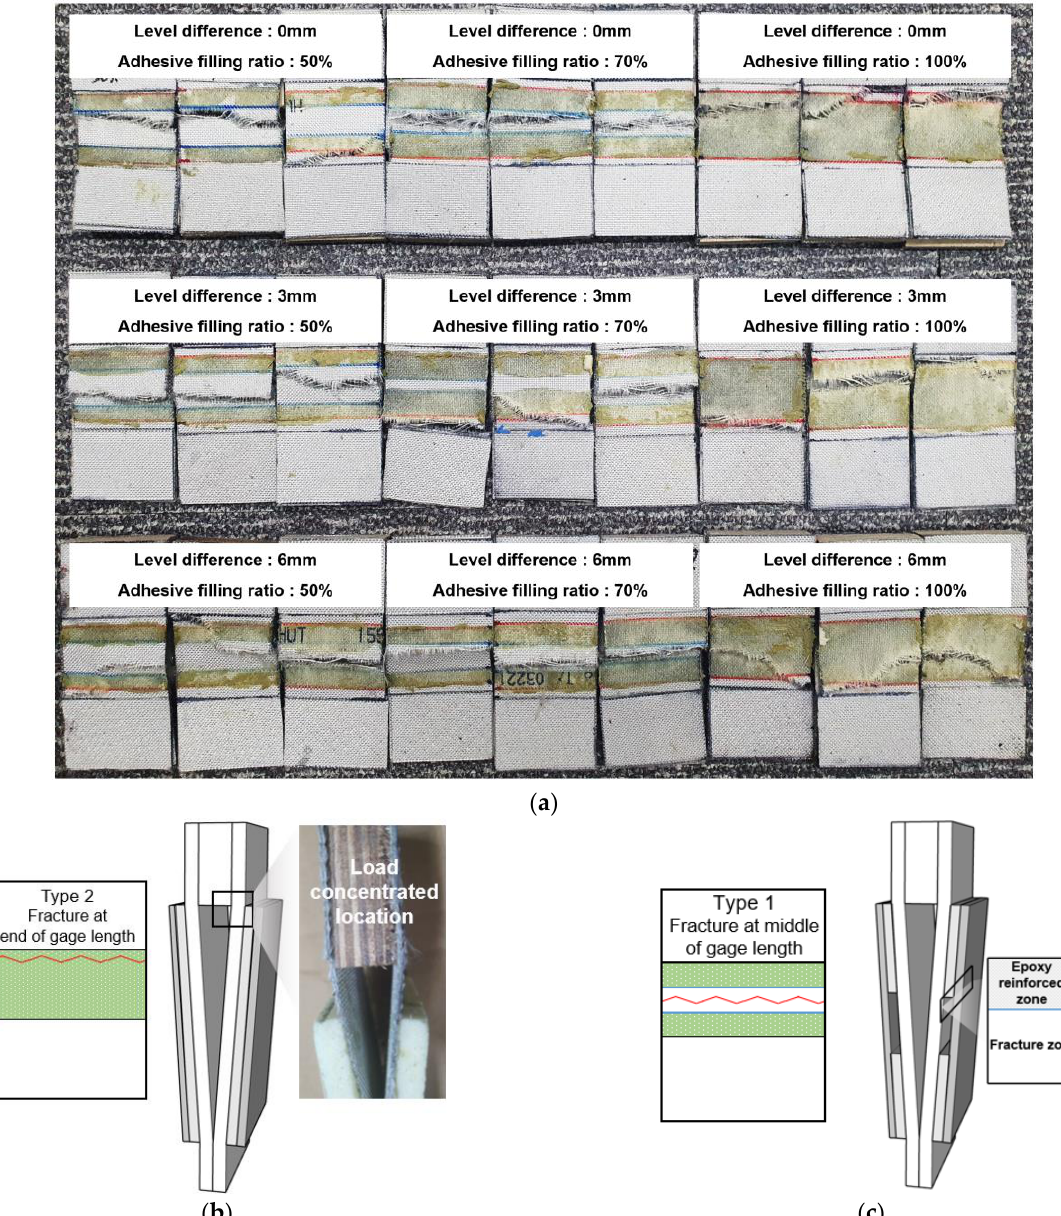
Figure 13. Fracture location in specimens according to the level difference and adhesive filling ratio: ( a ) images of tensile test specimens; schematic diagrams of a fracture ( b ) in the middle and ( c ) at the end of the gauge length.